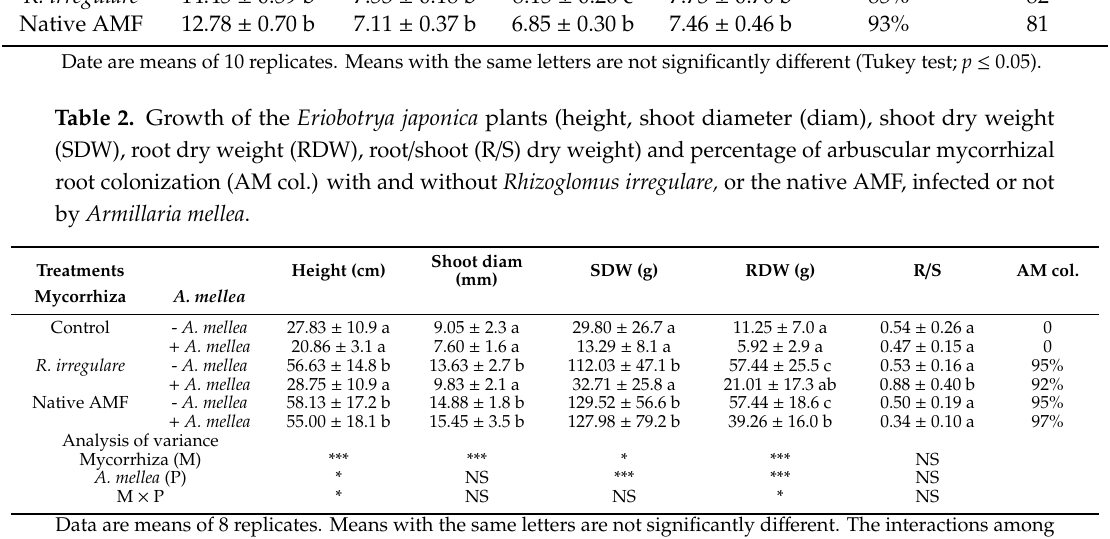
Table 1. Growth parameters measured on Eriobotrya japonica plants in sandy soil after 12 months growth (height, shoot diameter (diam.), shoot dry weight (SDW) and root dry weight (RDW), and percentage of arbuscular mycorrhizal root colonization (AM colonization) and relative mycorrhizal dependency (RMD) of the plants with and without colonization by Rhizoglomus irregulare or the native arbuscular mycorrhizal fungi (AMF). Shoot diam. SDW (g) RDW (g) Height (cm) (mm)